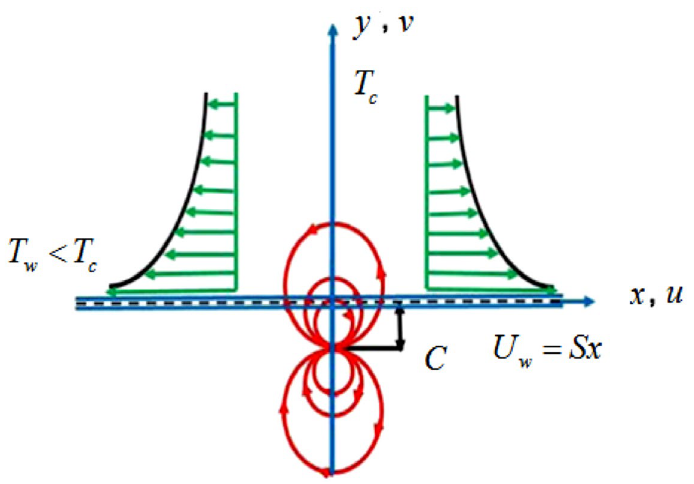
Figure 1. Schematic flow